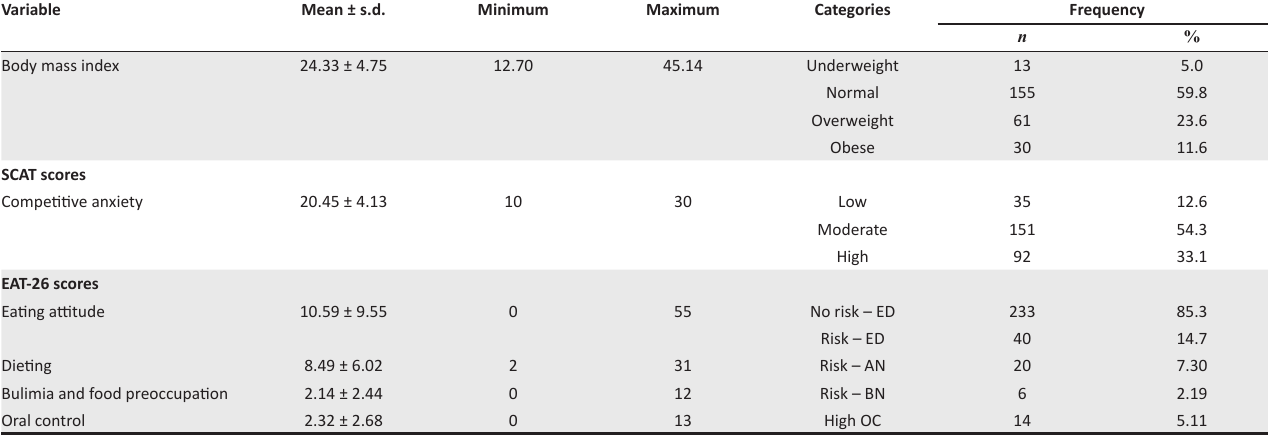
TABLE 2: Physical attributes, competitive anxiety (Sport Competition Anxiety Test scores) and eating attitudes (Eating Attitudes Test-26scores) of the sample.